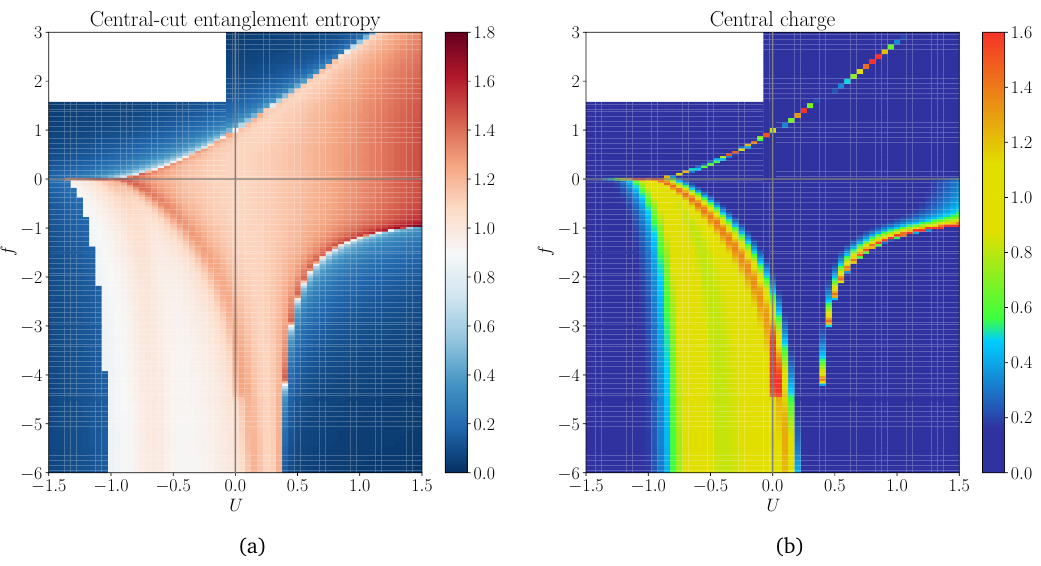
-ANNNP model. The 3